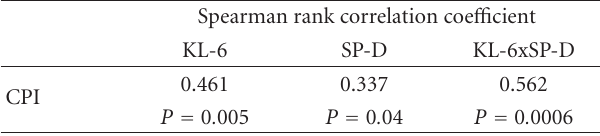
Table 5: Correlation of composite physiologic index with KL-6 and